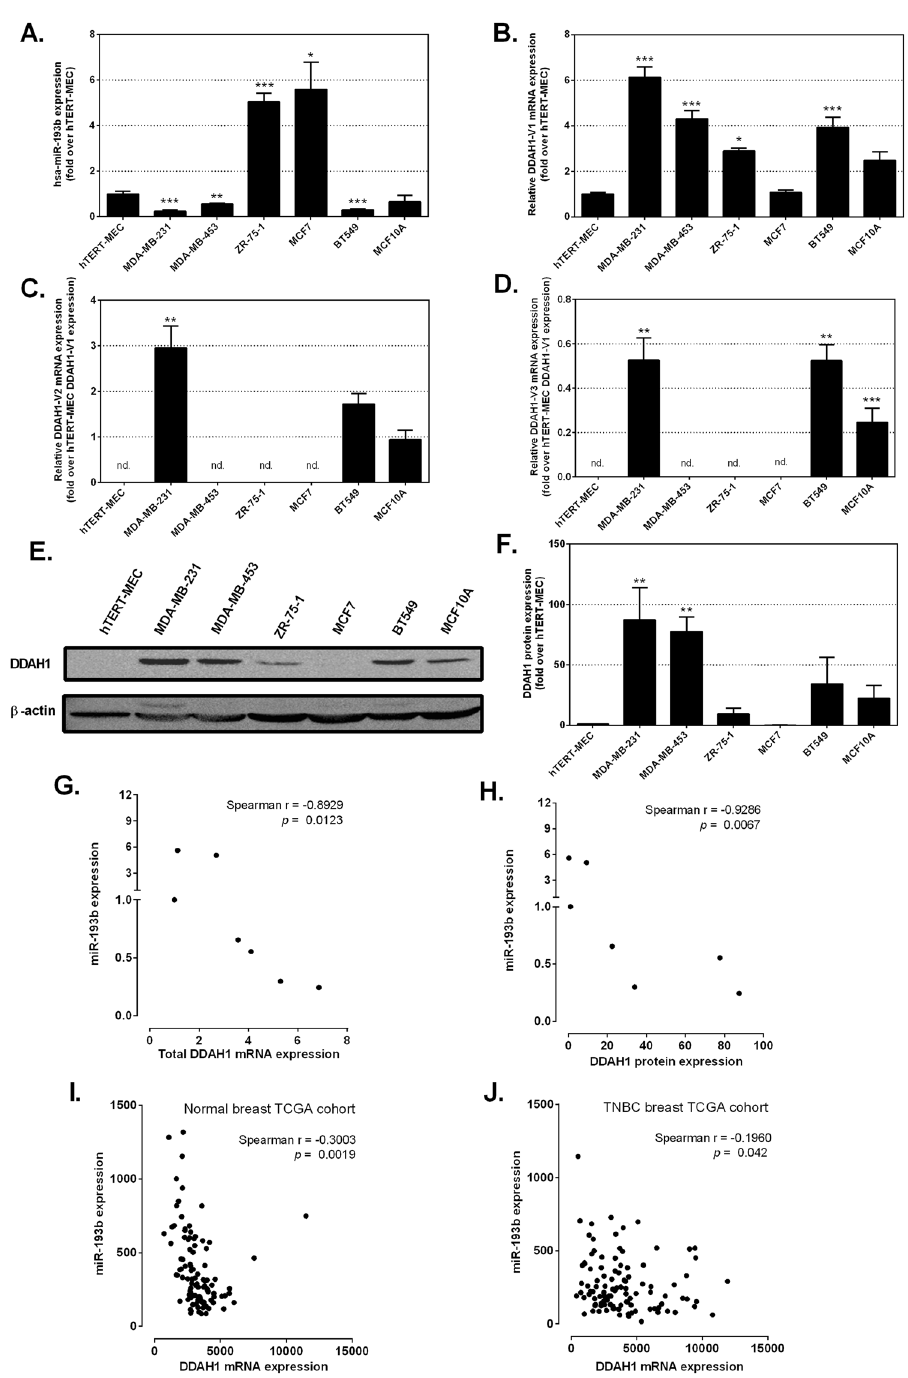
Figure 2. DDAH1 and miR-193b expression is negatively correlated in breast cancer cell lines. ( A , B , C , D ) Expression levels of miR-193b ( A ), DDAH1-V1 ( B ), DDAH1-V2 ( C ) and DDAH1-V3 ( D ) in breast cancer cell lines as assessed by qRT-PCR. Data are normalised to the housekeeping gene 18S (for DDAH1 variants) or RNU6-2 (for miR-193b) and presented relative to hTERT-MEC cells, which is set to a value of 1. ( E ) Expression of endogenous DDAH1-V1 (full length protein) in breast cancer cell lines as shown by a representative western blot, with ß-actin as a loading control. ( F ) Quantification of DDAH1 protein expression as in (E ) from at least two independent experiments, normalised to ß-actin expression and shown relative to DDAH1 expression in hTERT-MEC, set to a value of 1. Error bars represent SEM. * p < 0.05, ** p < 0.01 and *** p < 0.001 relative to expression in hTERT-MEC. ( G , H ) Spearman’s rank-order correlation analysis shows a significant inverse correlation between mean miR-193b expression and mean total DDAH1 mRNA ( G ) and protein ( H ) expression. Each data point represents a single cell line. Data are the average of at least two independent experiments performed in triplicate. ( I , J ) Spearman’s rank-order correlation analysis of The Cancer Genome Atlas (TCGA)/breast carcinoma (BRCA) dataset shows a significant inverse correlation between DDAH1 and miR-193b in normal breast specimens ( I ) and TNBC specimens ( J